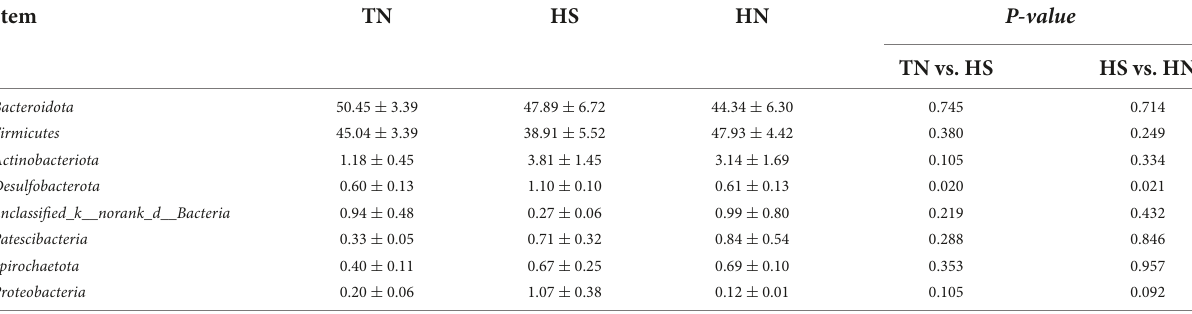
TABLE 8 Effects of niacin on rumen bacterial flora structure (phylum